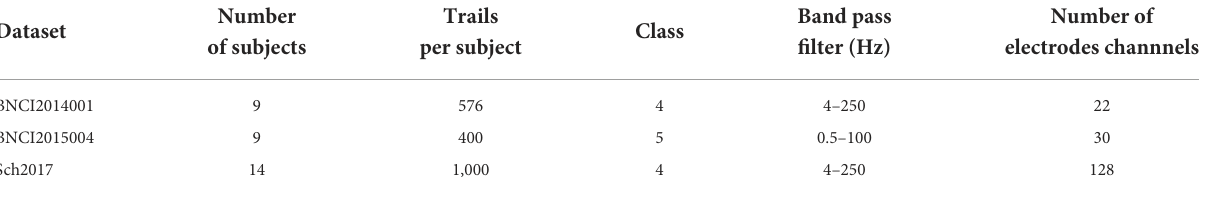
TABLE 1 Key information of the three MI-EEG datasets used for experiences.